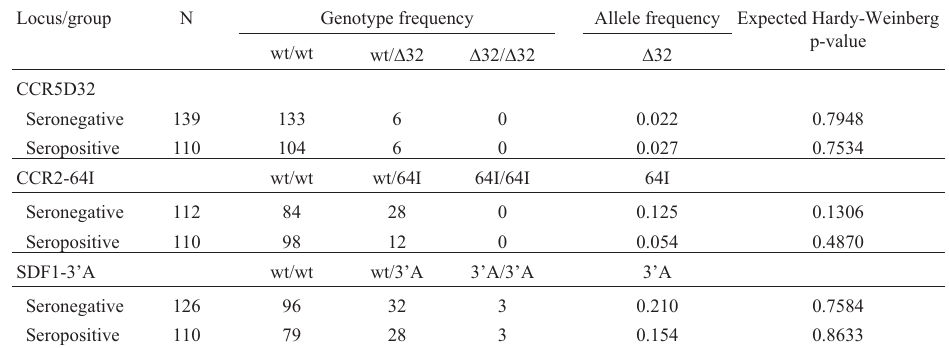
Table 1 - Allele and genotype frequencies of the CCR5, CCR2 and SDF-1 loci in Human immunodeficiency virus (HIV) seropositive and seronegative individuals from Belém. Locus/group N Genotype frequency Allele frequency Expected Hardy-Weinberg